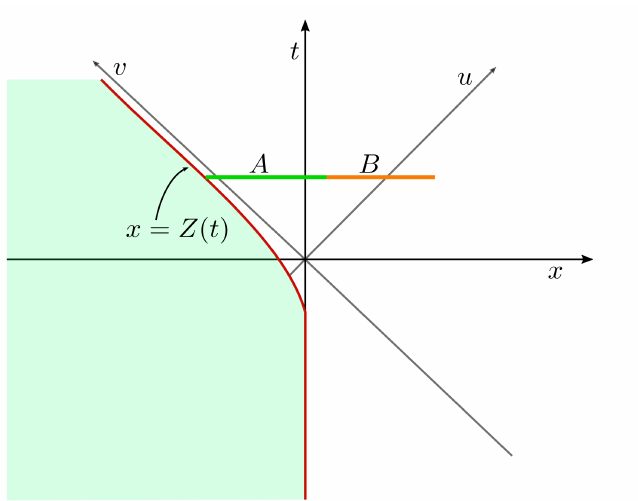
Figure 6. Schematics of two adjacent intervals A = [( t, 0) , ( t, x 1 )] and B = [( t, x 1 ) , ( t, x 2 )] in the moving mirror BCFT. Figure modified from